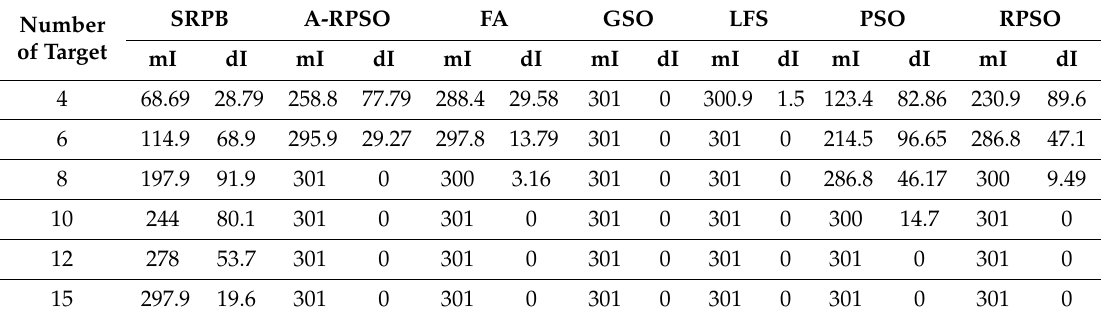
Figure 15. The time to find sources. ( a ) mI of the time to find the first target; ( b ) dI of the time to find the first target; ( c ) mI of the time to find the half targets; ( d ) dI of the time to find the half targets. Table 1. mI and dI of the time to find the last target.